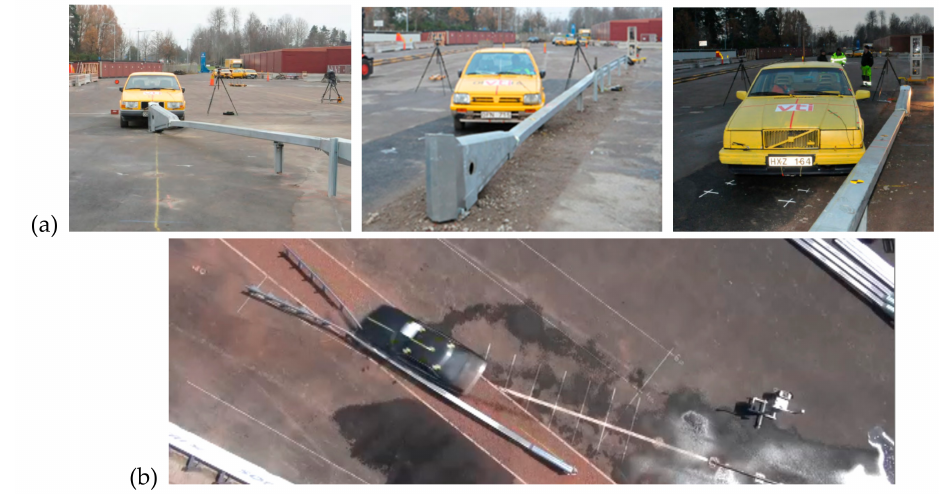
Figure 12. Field tests ( a ) Sweden, ( b ) Poland.